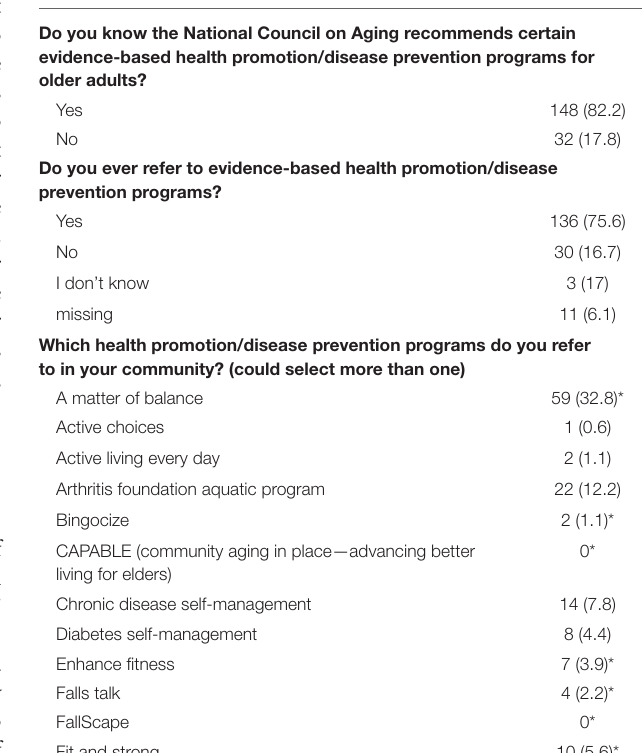
TABLE 4 | Knowledge and use of community interventions among physical therapists and physical therapist assistants who conduct community-based fall screenings ( n =